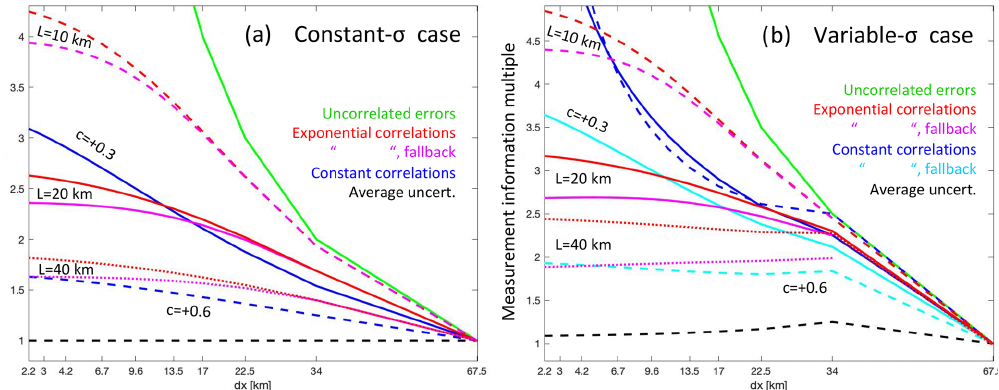
Figure 2. The measurement information content ( σ − 2 avg /σ − 2 o ) of the 10s average produced by several different error correlation models as a function of the linear separation of the data points, (cid:49)x , for two simple example cases: (a) all averaged values having the same uncertainty (cid:104) 1 (cid:105) + j − 1 = σ − 1 o ( σ j = σ o ) and (b) the values having uncertainties that vary as σ − 1 . For models based on the number of data points, J , we j J − 1 2 convert to (cid:49)x = ( 67 . 5km )/J for plotting on the x axis. The correlation models are independent errors (green), average uncertainty (black dashed), constant correlations (blue), and constant correlations using the fallback uncorrelated mean (cyan), assuming for the latter two models correlations of c = + 0 . 3 (solid) and c = + 0 . 6 (dashed). Also given are the exponential correlation model results with the original average from Eq. (28) (red) and with the fallback uncorrelated mean (magenta), in both cases for length scales of 10km (dashed), 20km (solid), and 40km (dotted).